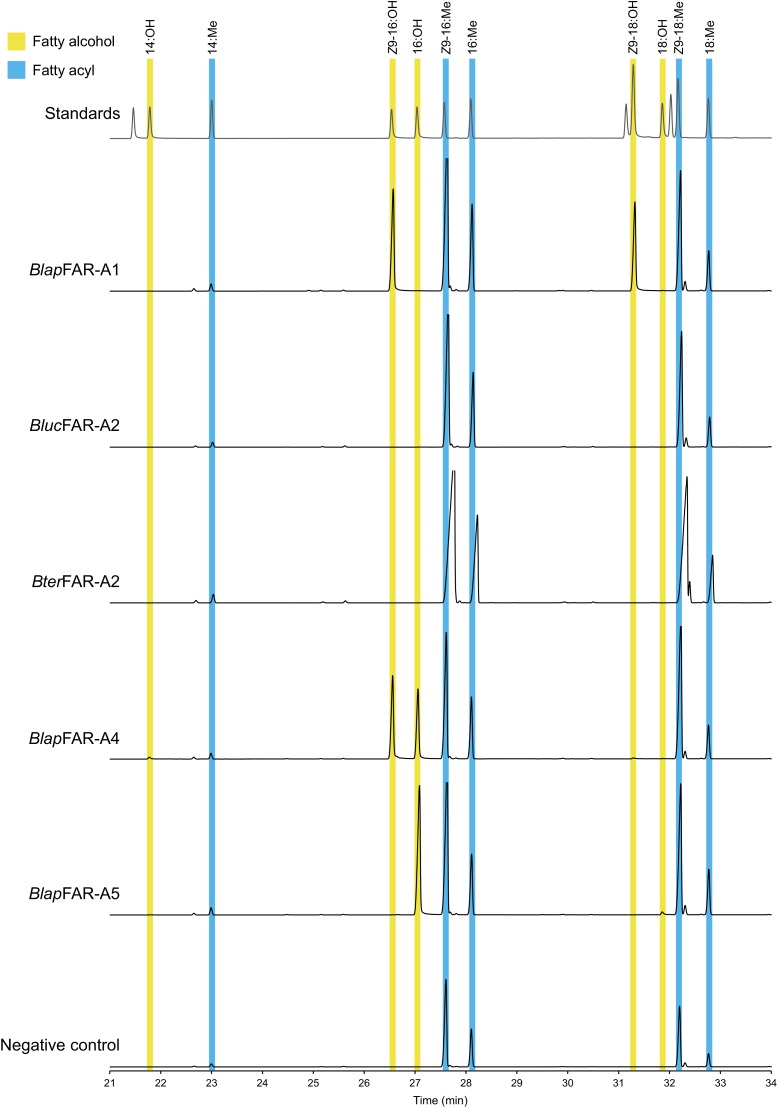
Fatty alcohol production in yeasts expressing bumble bee FARs specific for long chain fatty acyls.The chromatogram traces show fatty alcohol and fatty acyl methyl ester profiles from lipid extracts of yeast expressing bumble bee FARs which are specific for long chain fatty acyls (C14–C18), that is BlapFAR-A1, BlucFAR-A2, BterFAR-A2, BlapFAR-A4, BlapFAR-A5.